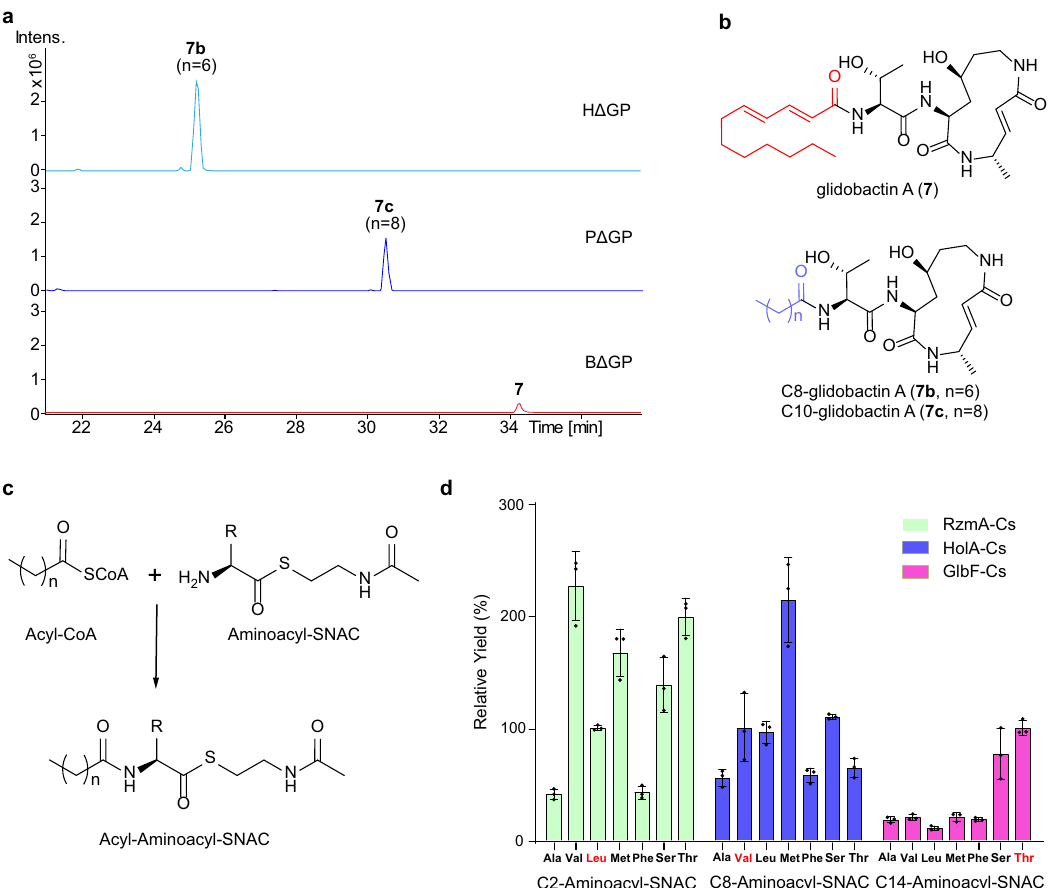
Fig. 3 Cs domain swapping experiments on the glidobactin synthase GlbF and in vitro assay of Cs speci fi city for acceptor substrates. a , b Production analysis of full-length domain swapping of GlbF-Cs (B Δ GP) with HolA-Cs (H Δ GP) and GlpC-Cs (P Δ GP) in S. brevitalea DSM 7029 showed an exchange of the acyl chains with different yields. EICs at m / z = 521.333 ([M + H] + , 7 ) for 7029B Δ GP, and 469.3021 ([M + H] + , 7b ) for 7029H Δ GP, and at m / z = 497.333 ([M + H] + , 7c ) for 7029P Δ GP. c , d In vitro assay of Cs speci fi city for acceptor substrates. The fi nal products were quanti fi ed by comparison with the EIC peak area of native SNACs (100%), i.e., for RzmA-Cs, every set of tests was quanti fi ed with products of L-Leu-SNAC. The native SNACs are marked in red. Experiments were conducted in triplicates ( n = 3), data are presented as mean values + / − SD, and detailed information is given in the “ Methods ”